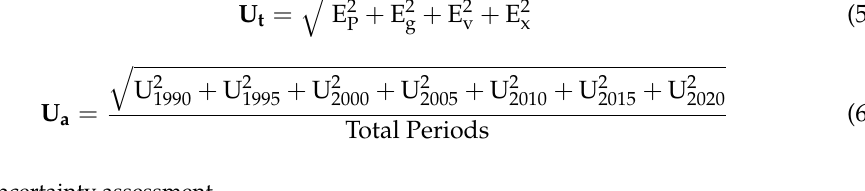
Table 2. Uncertainty